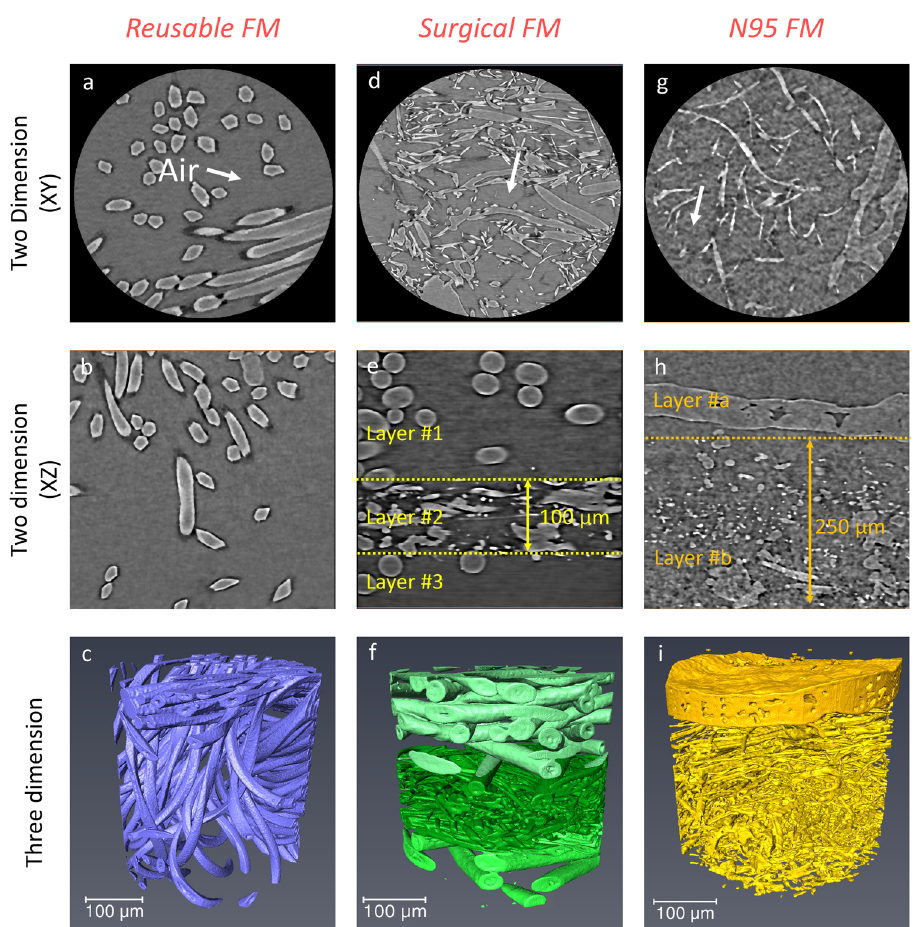
Fig. 1 3D microstructures of the three commercial face masks (FMs) obtained by high-resolution X-ray tomography. The X-ray micro-CT images of the reusable ( a – c ), surgical ( d – f ) and N95 ( g – i ) face masks are reconstructed by using advanced iteration algorithm. The extracted cross-sectional slices in the X ─ Y ( a , d , g ) and X ─ Z ( b , e , h ) planes (X-ray attenuation depicted through a grayscale) show that each sample has two phases, namely fi bres and air. The surgical face mask has three layers within the FOV whereas two layers are observed in N95. 3D microstructures of the reusable ( c ), surgical ( f ) and N95 ( i ) face masks are rendered (removing the pore phase) in purple, green and yellow, respectively. mask (Fig. 2a – c), the surgical mask (Fig. 2d – f) and the N95 mask Table 1 The quanti fi cation of volume fraction and speci fi c (Fig. 2g – i) are presented. To verify the accuracy of the PNM and surface area extracted from the reusable, surgical and N95 provide an overview of the arrangement and distribution of the face pores, 3D fi brous structures are manually overlapped with pores as shown in the fi rst column of Fig. 2. The spheres and cylinders represent pores and throats (second column), respectively. All spheres (the radius of pores ranges from 0 to 50 µm) and throats are automatically assigned with different colours according to their equivalent radius to indicate the porosity and pore connectivity. For instance, spheres with the largest diameter were marked in red whereas those with the smallest diameter were labelled in blue. In Fig. 2b, for the reusable mask, nearly 12 larger spheres ( Φ pore > 60 µm) occupy most of the sample volume and there are few neighbouring smaller pores. The percentages of the largest pores ( Φ pore > 90 µm) are ca. 10% (reusable mask, Fig. 2c) and ca. 2.5% (surgical mask, Fig. 2f), respectively. By contrast, for the N95 mask (Fig. 2h, i), there are no pores (labelled in either mixture of nano- and micro- fi bres, the N95 mask has highest yellow or red) where the diameter is larger than 65 µm in the speci fi c surface area ( S area-N95 = 0.64) than the surgical mask FOV. Instead, nearly 50% spheres are smaller than 30 µm and, ( S area-surgical = 0.40) and the reusable mask ( S area-reusable = 0.27). they are homogeneously distributed in same FOV. Interestingly, PNM is performed for a better understanding of pores in the sandwich structure of the surgical mask, the spheres exhibit distribution on the droplet transmission (Fig. 2 and Supplemen- a similar characteristic (Fig. 2e). Speci fi cally, the sphere size in the tary Movie 2). The visualisations ( fi rst and second columns) and interior layer (layer #2) seems considerably smaller ( Φ pore < 15 – 30 µm) than those in the exterior layers (Layer #1 and #3). pore diameter ( Φ pore ) distribution (third column) of the reusable